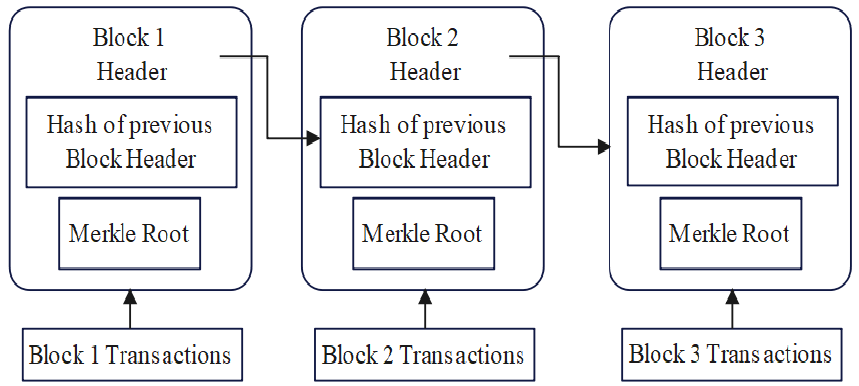
Figure 3. Structure of block header and Merkle root function.